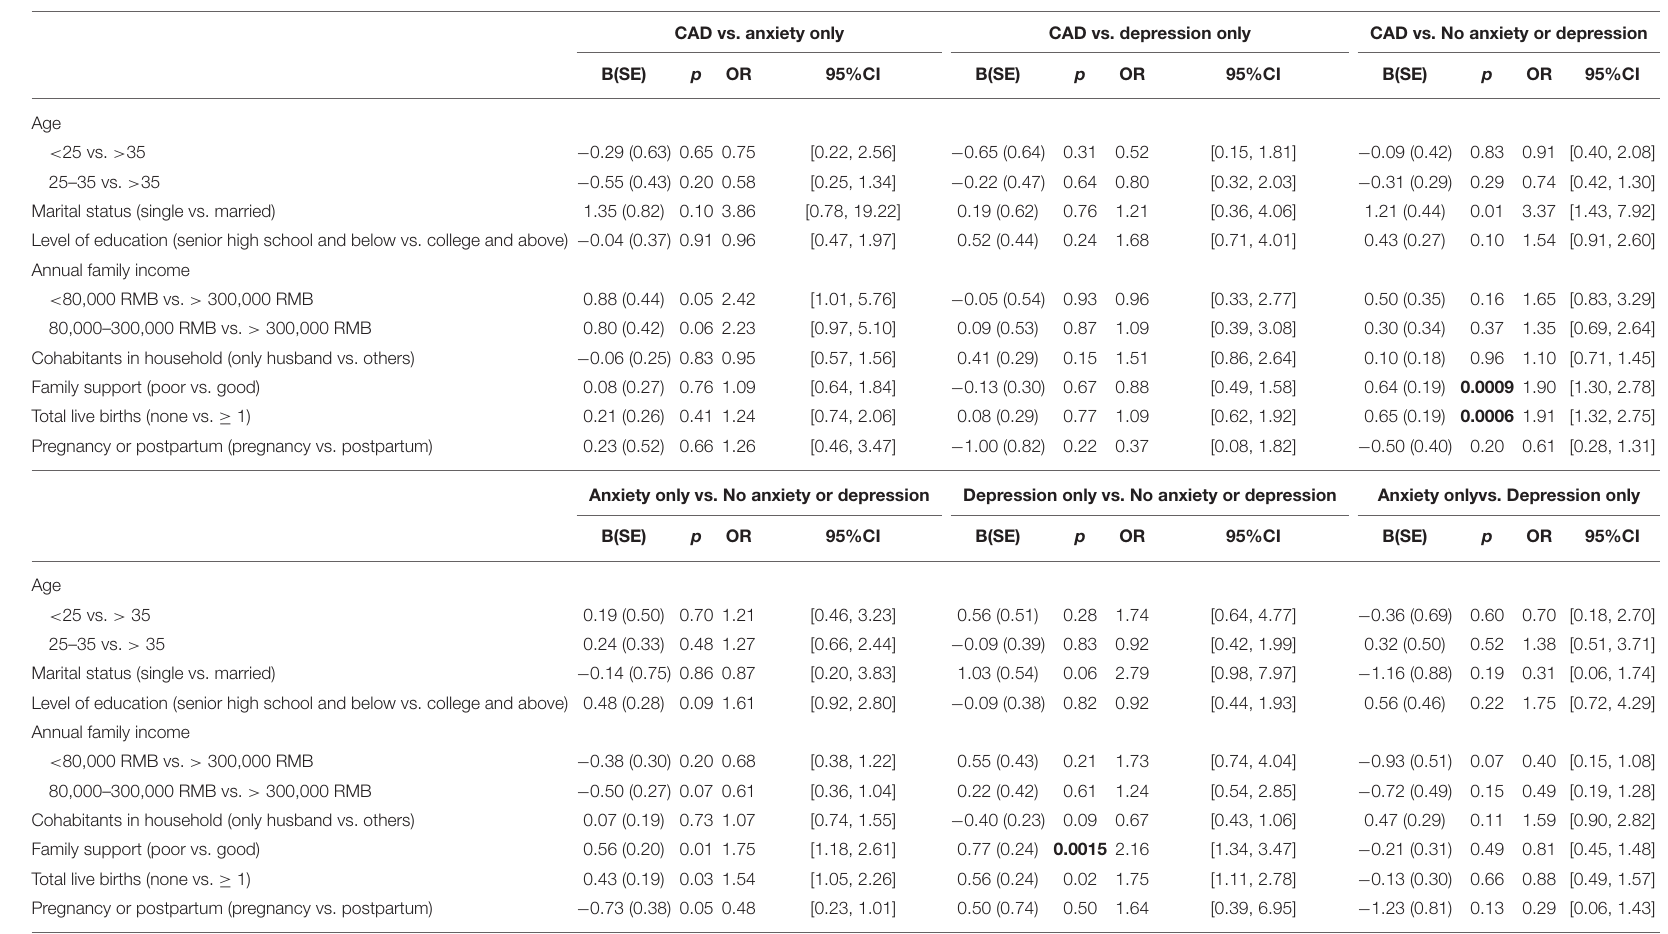
TABLE 3 | Predictors of participants in comorbid anxiety and depression (CAD) group vs.“anxiety only,” depression only,” and “no anxiety or depression” groups. CAD vs. anxiety only CAD vs. depression only CAD vs. No anxiety or